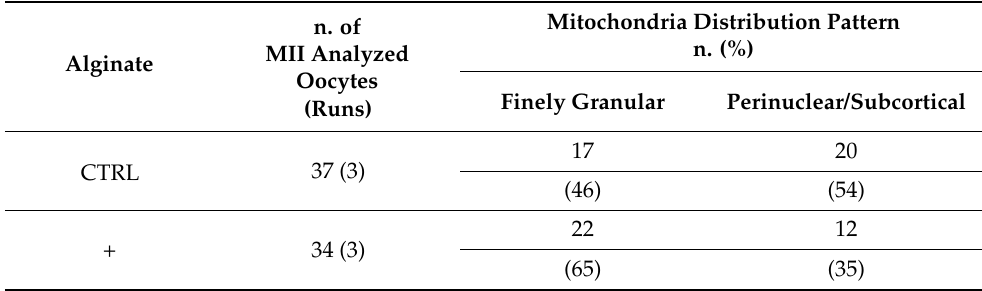
Table 7. Effects of mIVM in alginate-filled supports on MII sheep oocyte mitochondria distribution pattern.